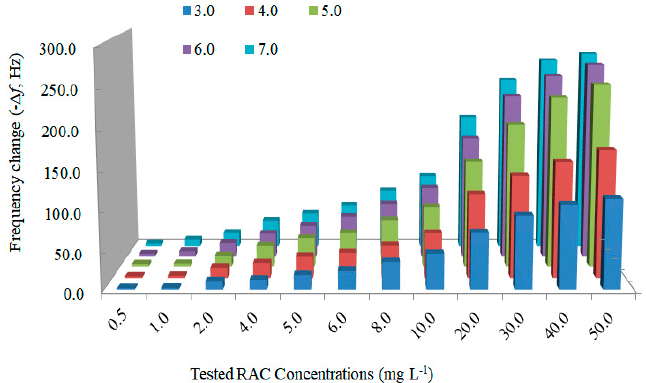
Figure 4. Comparison of the frequency response of the developed piezoelectric chip using different amounts of RAC imprinted material at the concentration range of 0.5–50.0 mg L − 1 .